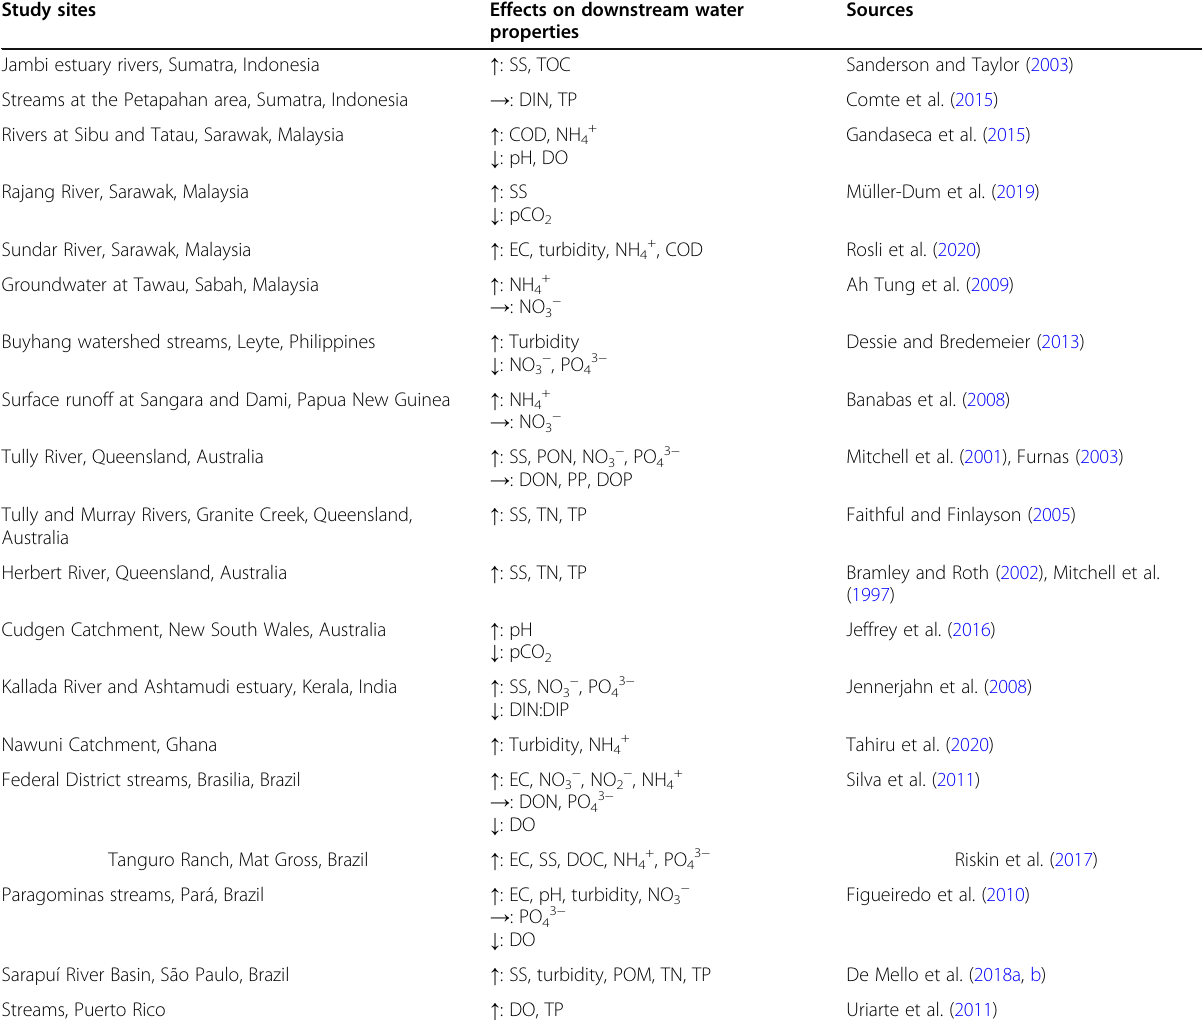
Table 4 A summary of the effects of agriculture on the downstream riverine and estuarine water properties. When most minerals (e.g., Na + , Mg 2+ , Cl − , K + , Ca 2+ ) increased, they were collectively described as EC increased. The arrows before the water properties indicate that the subsequent water properties increased ( ↑ ), decreased ( ↓ ), or did not change ( → ). See the list of abbreviations for the water properties